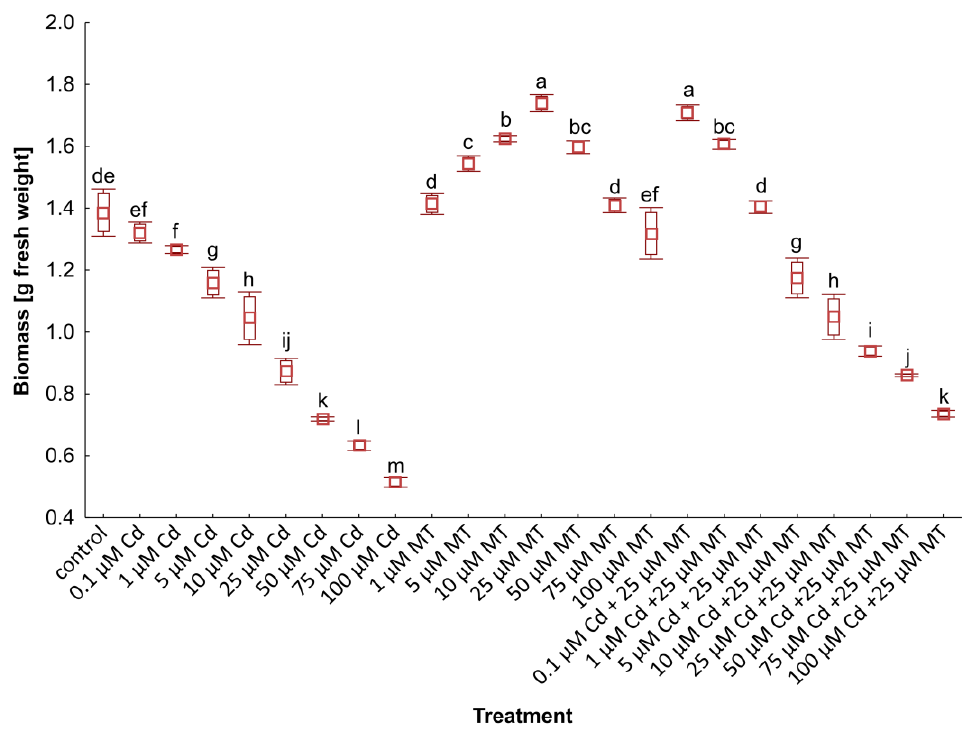
Figure 1. The biomass of W. arrhiza exposed to cadmium (Cd) or/with melatonin (MT) after 7 days of cultivation. The square represents the mean ( n = 5, biological replicate). The lower and upper hinges correspond to the lower and upper bounds of the 95% confidence interval of the means. The lower and upper whiskers extend from the hinge to the mean ± standard deviation. Means with the same letters are not significantly different ( p ≥ 0.05) according to Tukey’s post hoc test.